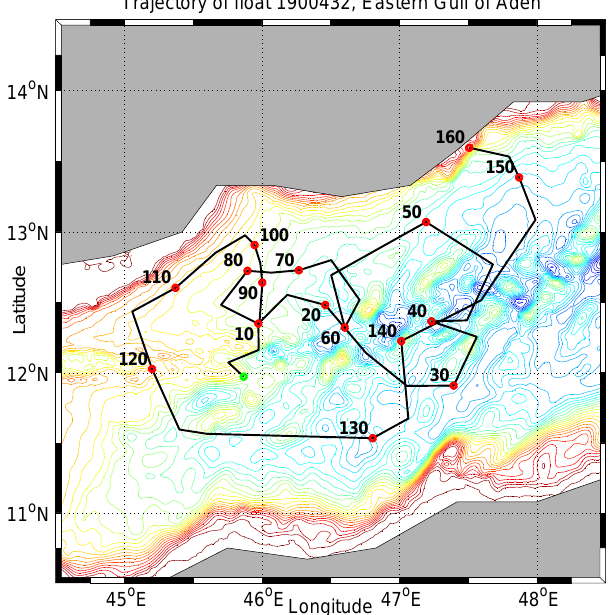
Fig. 2. Trajectory of float 1900432 in the Gulf of Aden, super- imposed on bathymetry; the green dot is the starting point of the Figure 2: Trajectory of float 1900432 in the Gulf of Aden, superimposed on bathymetry; trajectory; positions every 10 days are indicated by a red dot. the green dot is the starting point of the trajectory; positions every 10 days are indicated by a red dot.